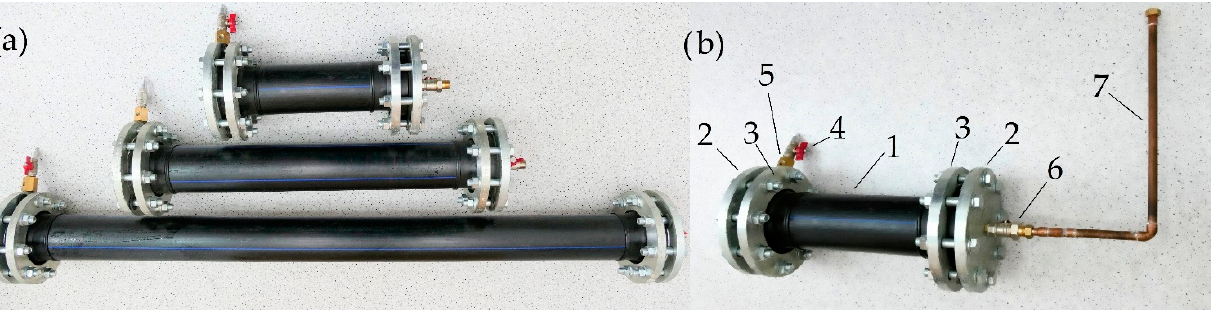
Figure 3. Additional pipes used in experimental study. ( a ) Additional pipes no. 1,2 and 3, ( b ) Additional pipe no. 1: 1—HDPE pipe, 2—steel lids, 3—steel rings, 4—vent valve, 5—pressure sensor socket, 6—shut-off valve, 7—connection pipe.